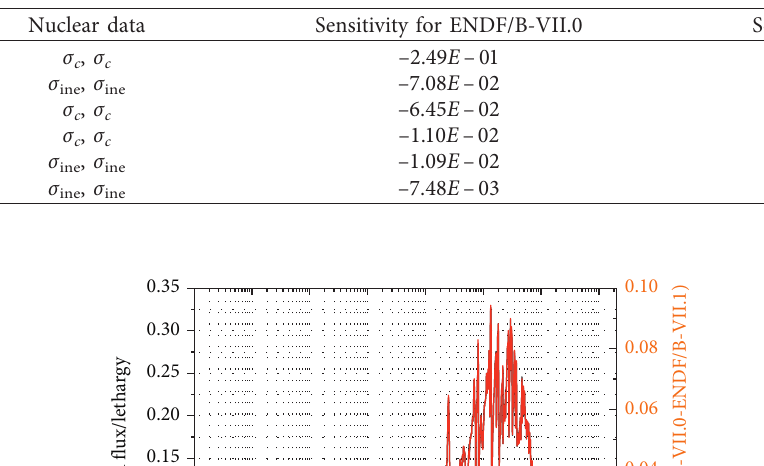
(negative direction). eff